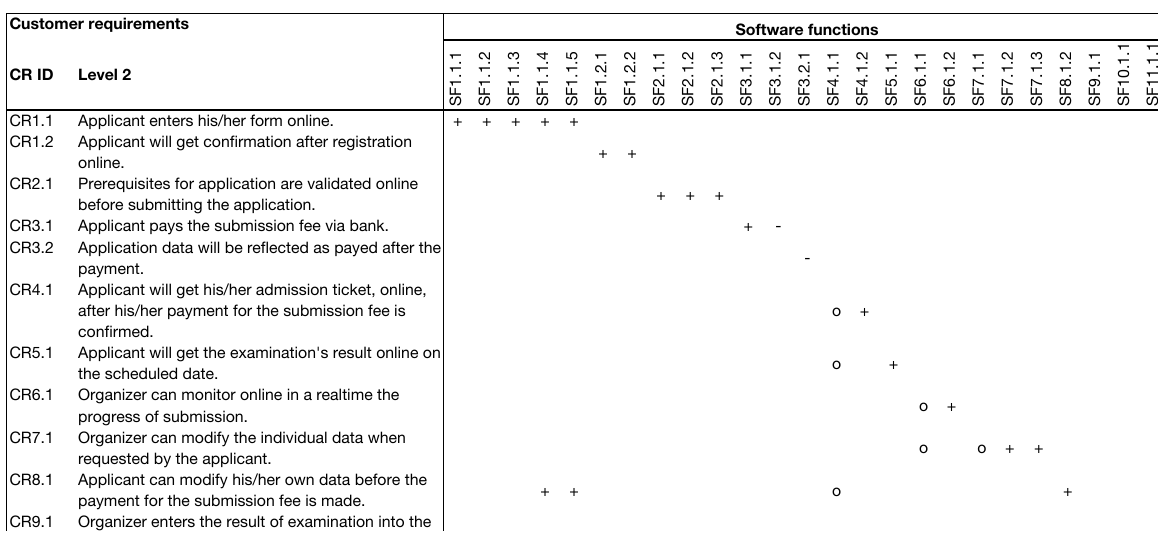
Table 4. Relationships between the customer requirements and the software functions (excerpt)